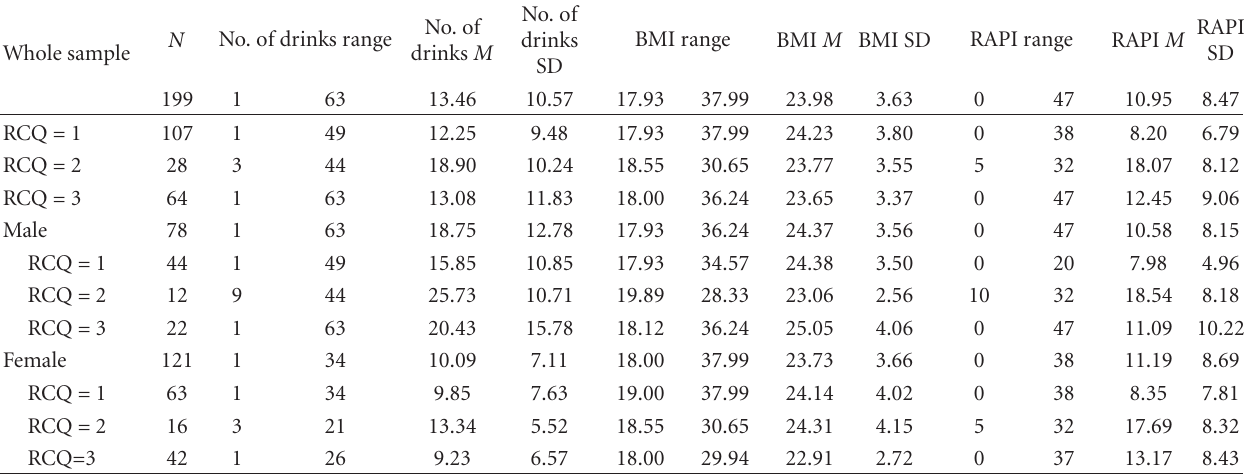
Table 1: Basic characteristics of participants ( N = 199).